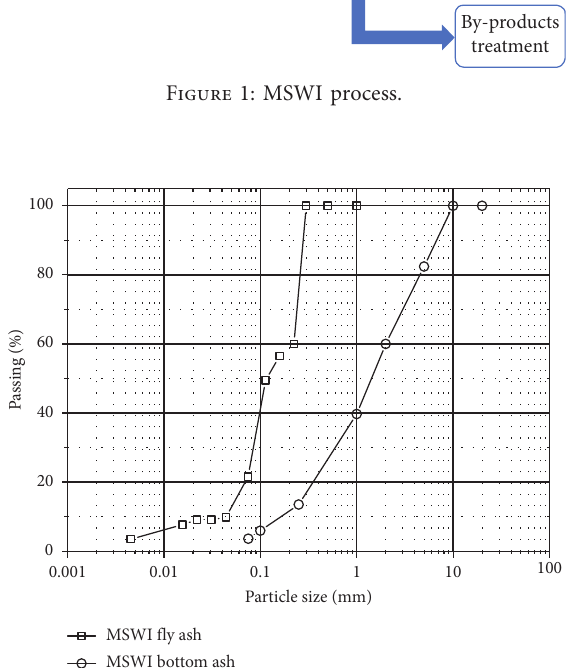
Figure 2: Particle size distribution of MSWI fly ash and bottom Table 1: Compounds of MSWI fly ash and bottom ash.